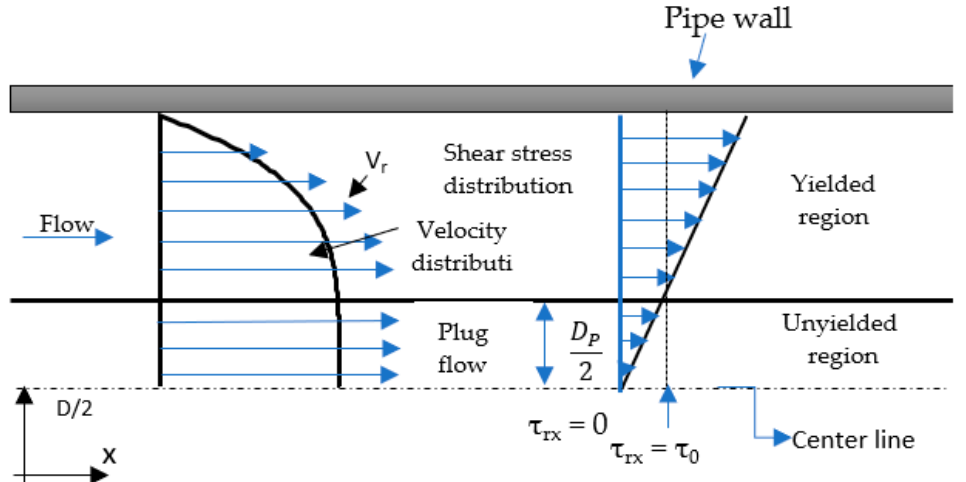
Figure 1. Velocity distribution in fully developed laminar flow for Herschel–Bulkley fluid in a circular pipe.